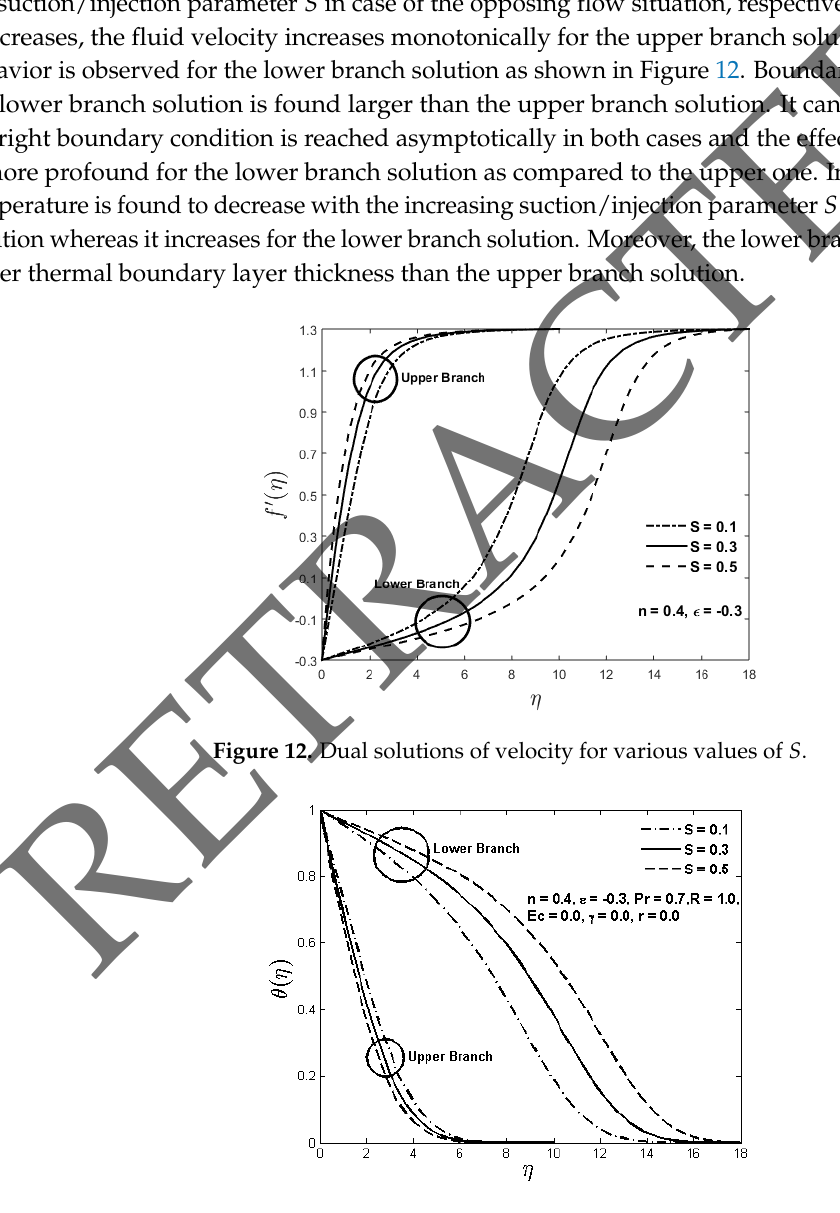
Figure 13. Dual solutions of temperature for various values of S